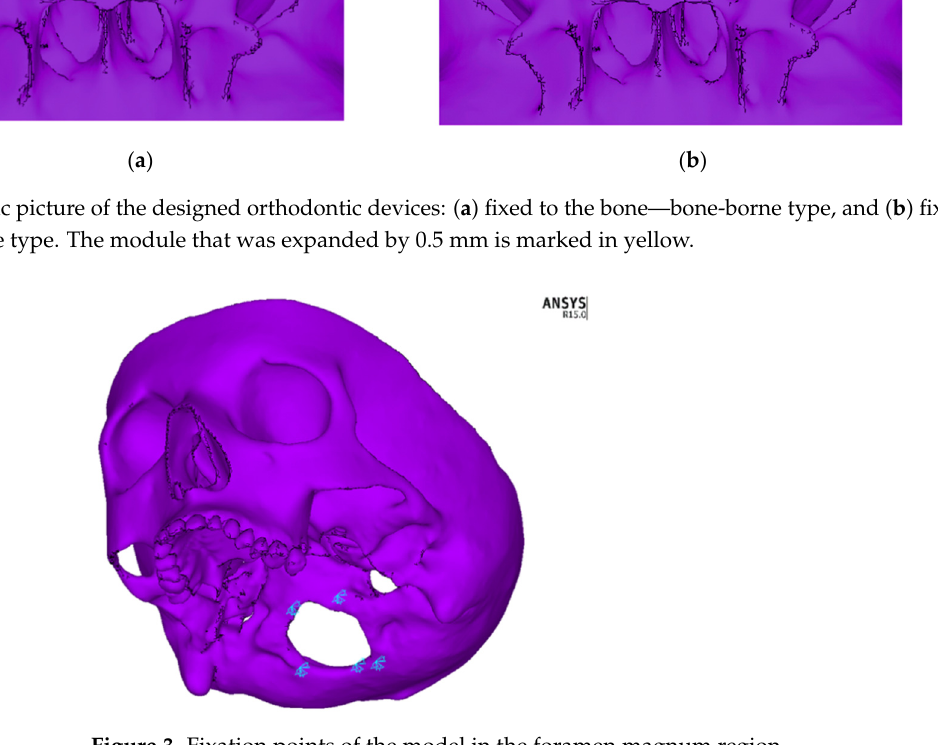
Figure 3. Fixation points of the model in the foramen magnum region.